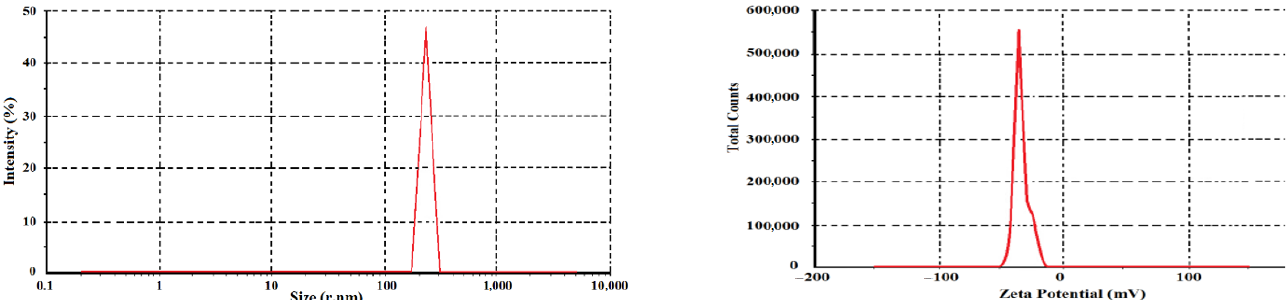
Figure 5. Distribution pattern of erythromycin ‐ loaded PLA nanoparticles.